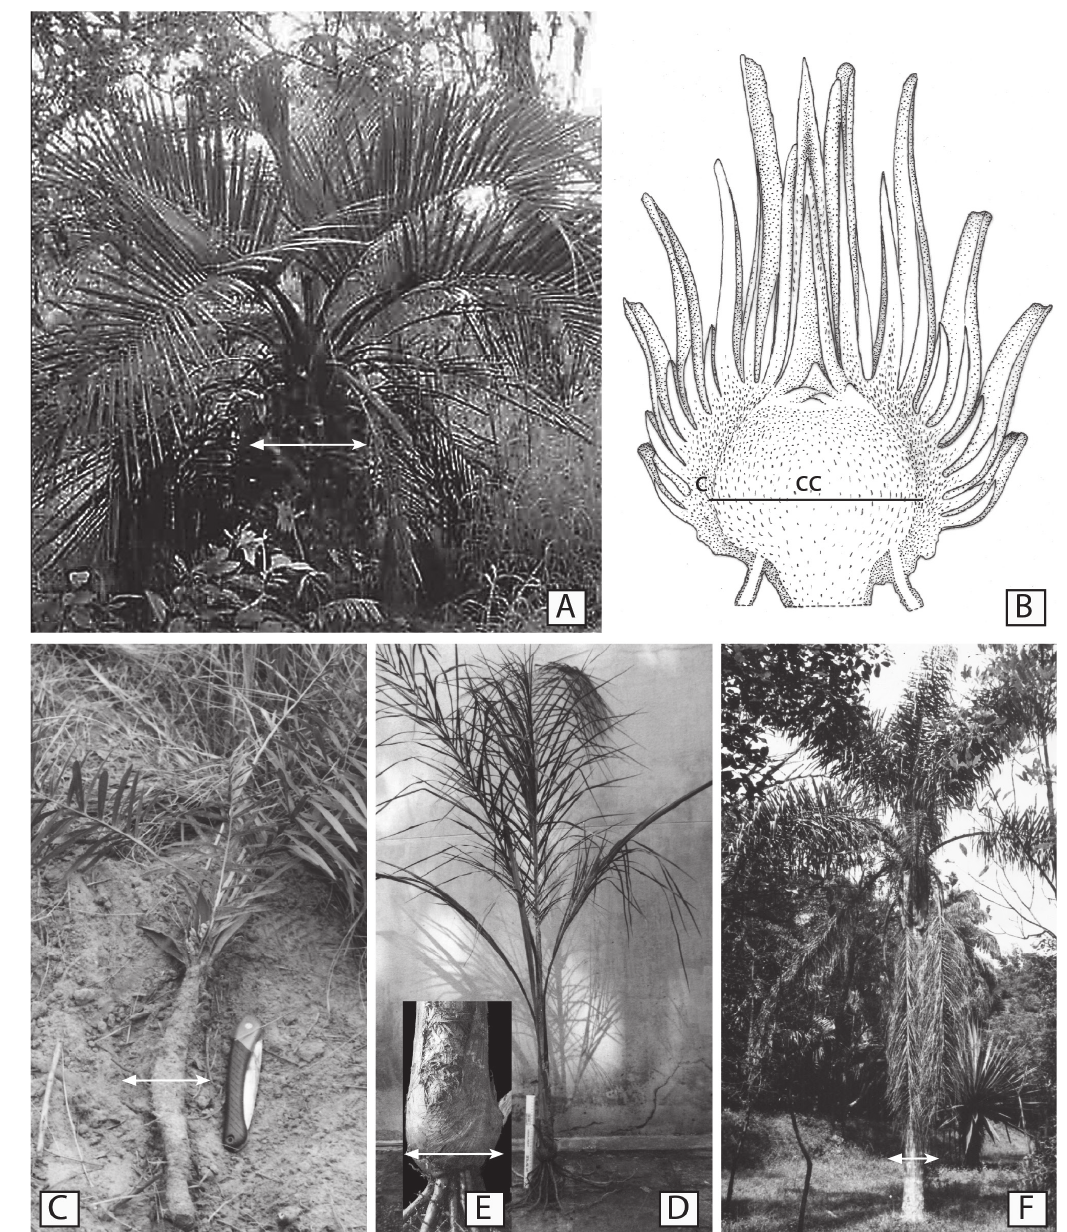
Figure 1 - Habit of the studied species. A - B. Butia paraguayensis . A. Short stem. B. Schematic diagram of the stem in longitudinal view. C: cortex, CC: central cylinder. C. Syagrus petraea . Subterranean stem. D - F. Syagrus romanzoffiana . D - E . young plant. E. Detail of the basal portion of the stem. F. Adult plant. Arrows: sectioned portions of the